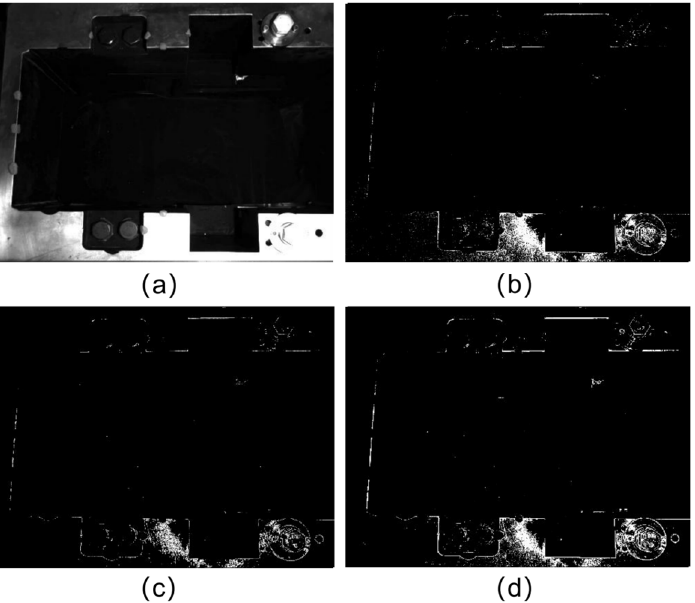
Figure 4. Results of edge detector: ( a ) Original image; ( b ) Laplacian’s Outcome; ( c ) Canny’s Outcome; ( d ) Sobel’s Outcome.